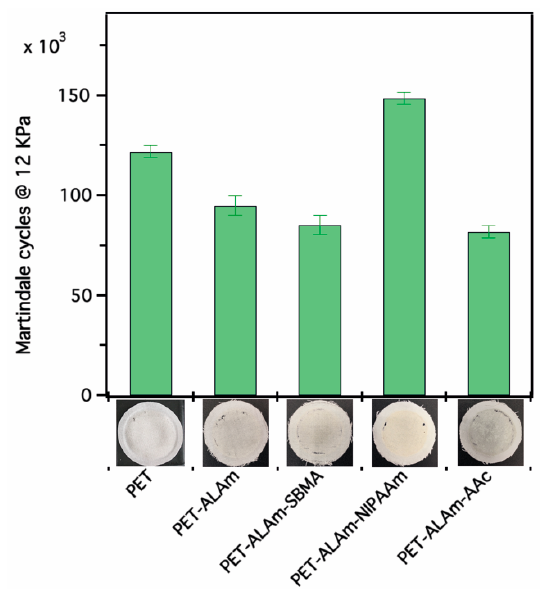
Figure 6. Martindale cycles of PET and hydrogel coated PET samples.